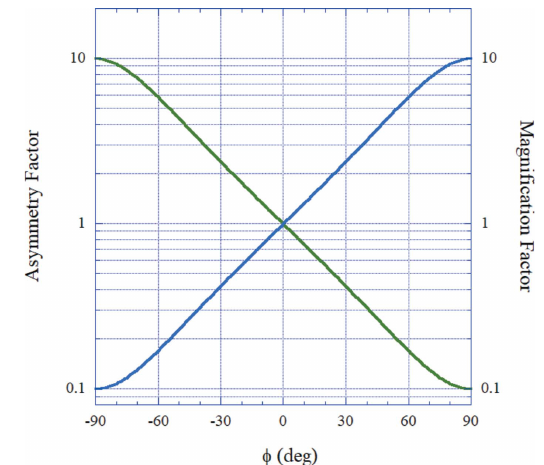
Figure 2 Calculated asymmetry factor (green line) and magnification factor (blue line) for a Si(220) crystal with an asymmetric angle of 14 (cid:4) at a wavelength of 0.112